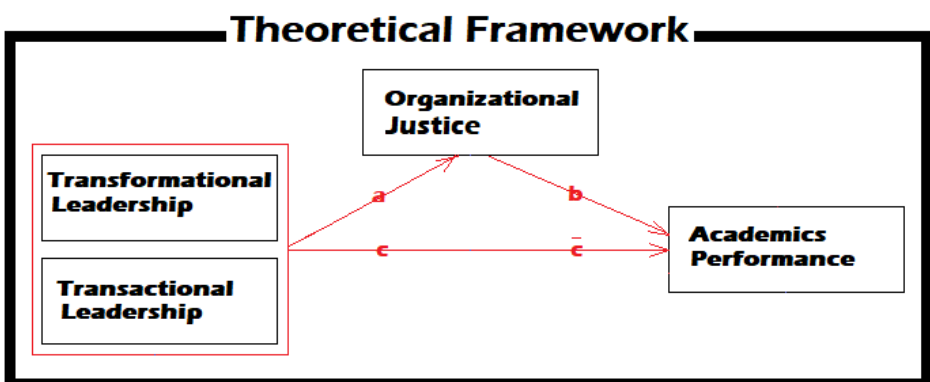
Figure 1. Theoretical